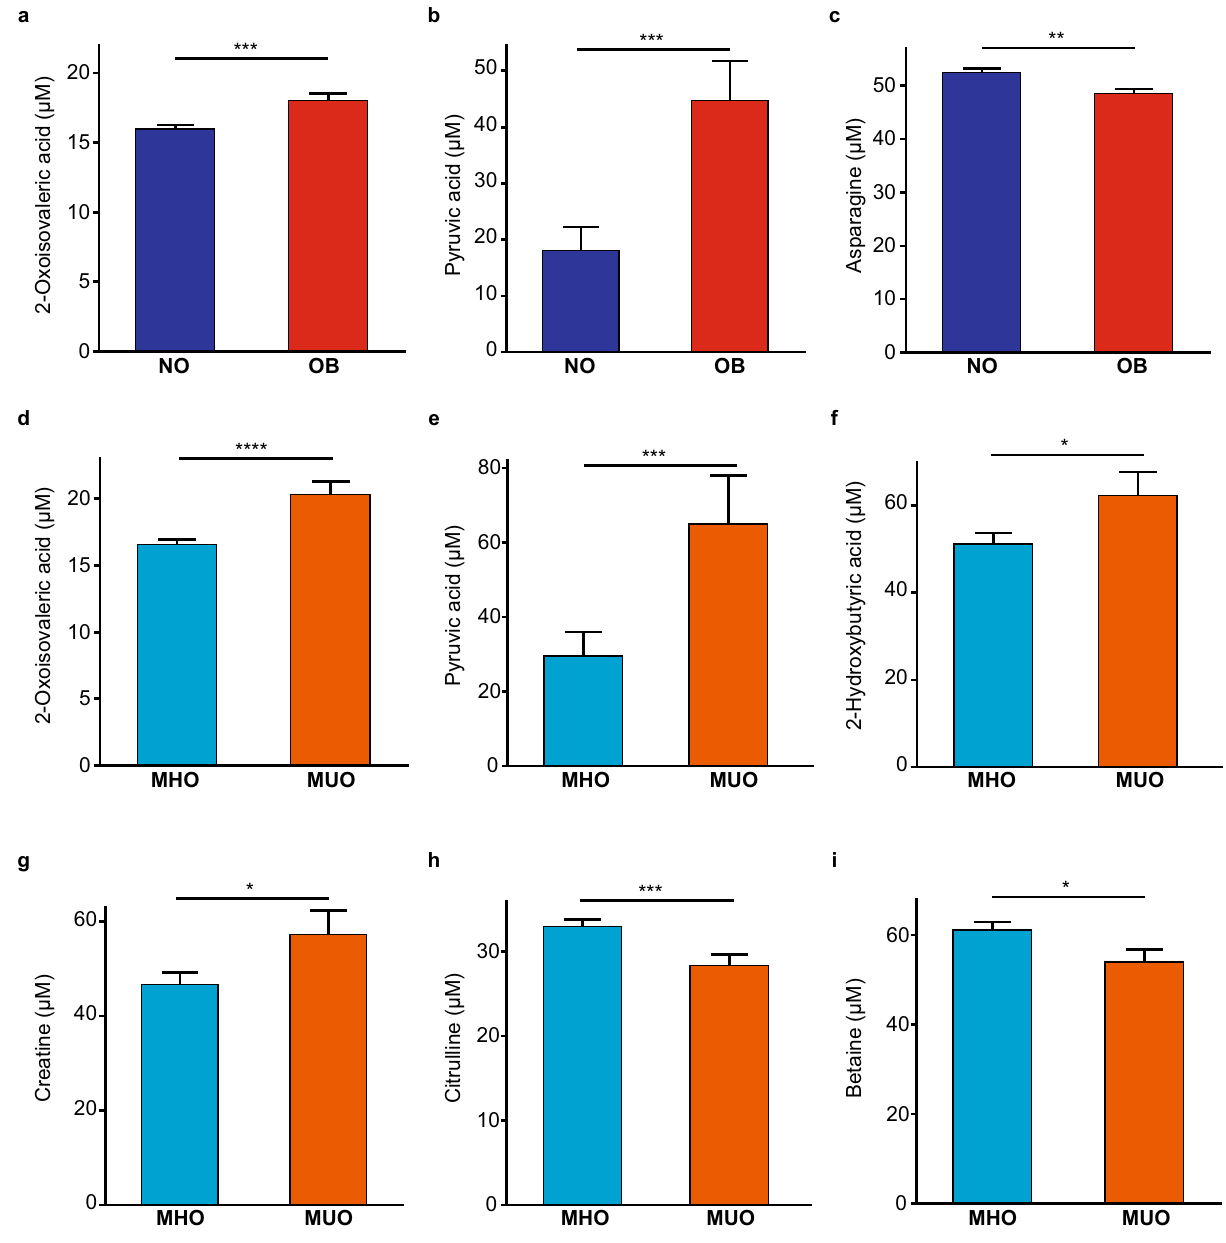
Figure 5. (a–c ) Composition of selected metabolites in serum of NO and OB. ( d–i) Composition of metabolites in serum of MHO and MUO. NO; non-obese (blue) (n = 81), OB; obese (red) (n = 59), MHO; metabolically healthy obese (light blue) (n = 54) and MUO; metabolically unhealthy obese (orange) (n = 21). Data are shown as mean ± SEM. Data were analyzed using unpaired t -test to compare groups. * p < 0.05; ** p < 0.01; *** p < 0.001; **** p <